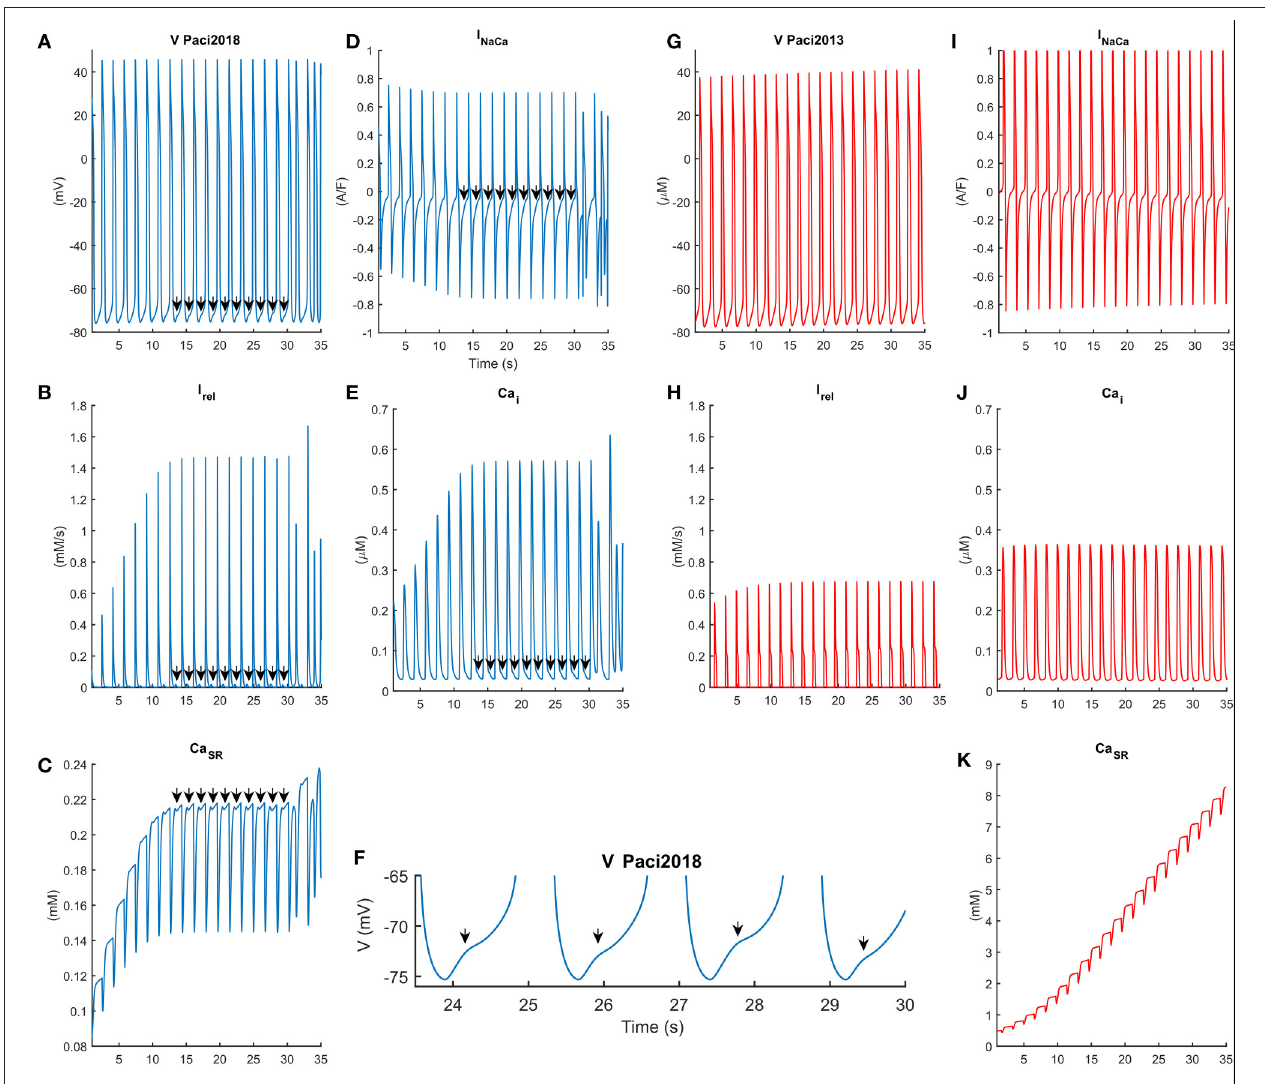
FIGURE 6 | Comparison of the behavior of the Paci2018 (in blue, A–F ) and the Paci2013 model (in red, G–K ) in case of spontaneous APs and Ca 2 + overload induced by hypercalcemia (Ca o = 3.945mM). In this condition both models can produce spontaneous APs, reported in (A,G) . The Paci2018 model shows a saturation of the sarcoplasmic Ca 2 + concentration (C) , after which reactivation of I rel (B) induces a distortion in the shape of the Ca 2 + transients (E) and in the inward component of I NaCa (D) , which corresponds to DADs in the membrane potential (A,F) in between t = [14, 30] s. At t = 30s a strong spontaneous release of Ca 2 + from SR is shown, which induces a spurious AP. On the contrary, the Paci2013 is not affected in these conditions and does not produce repolarization abnormalities (G)